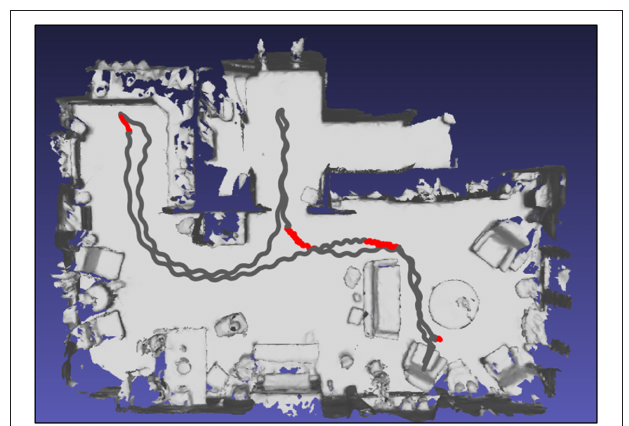
FIGURE 3 | Top view of a participant’s home environment as mapped with HoloLens with the route walked based on localization of the HoloLens in the mapped environment (gray trace, representing a single trial with HoloLens without Holocue) onto which the annotated freezing episodes are superimposed with red